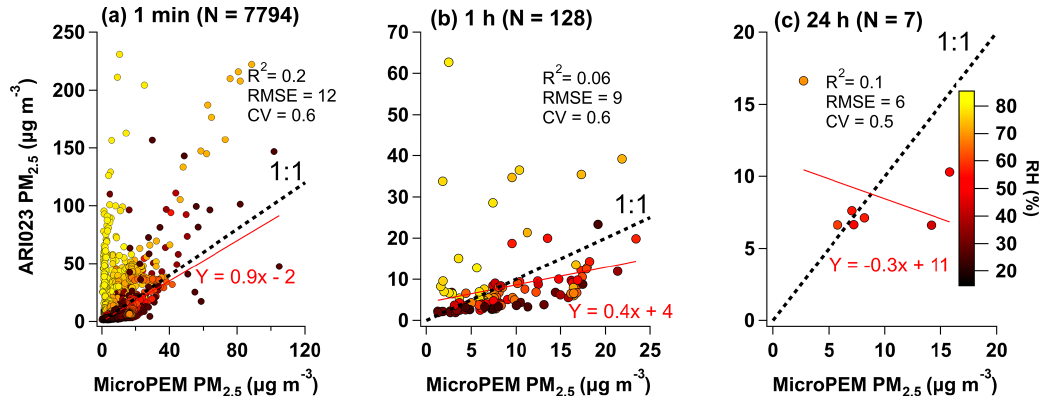
Figure 3. Scatterplots of RH-corrected PM 2 . 5 mass concentration measurements from the OPC-N2 versus filter mass-corrected PM 2 . 5 measurements from the MicroPEM at 1min (a) , 1h (b) , and 24h (c) averaging intervals. Data points are colored according to RH (%) conditions. N represents the number of data points. Linear fit lines and regression coefficients ( m,b ) are given in red as Y = mx + b . Additional metric values are inset: R 2 is the coefficient of determination, RMSE is root-mean-square error (units of µgm − 3 ) assuming the MicroPEM is the reference instrument, and CV is coefficient of variation. The dashed black line is a 1 : 1 line.